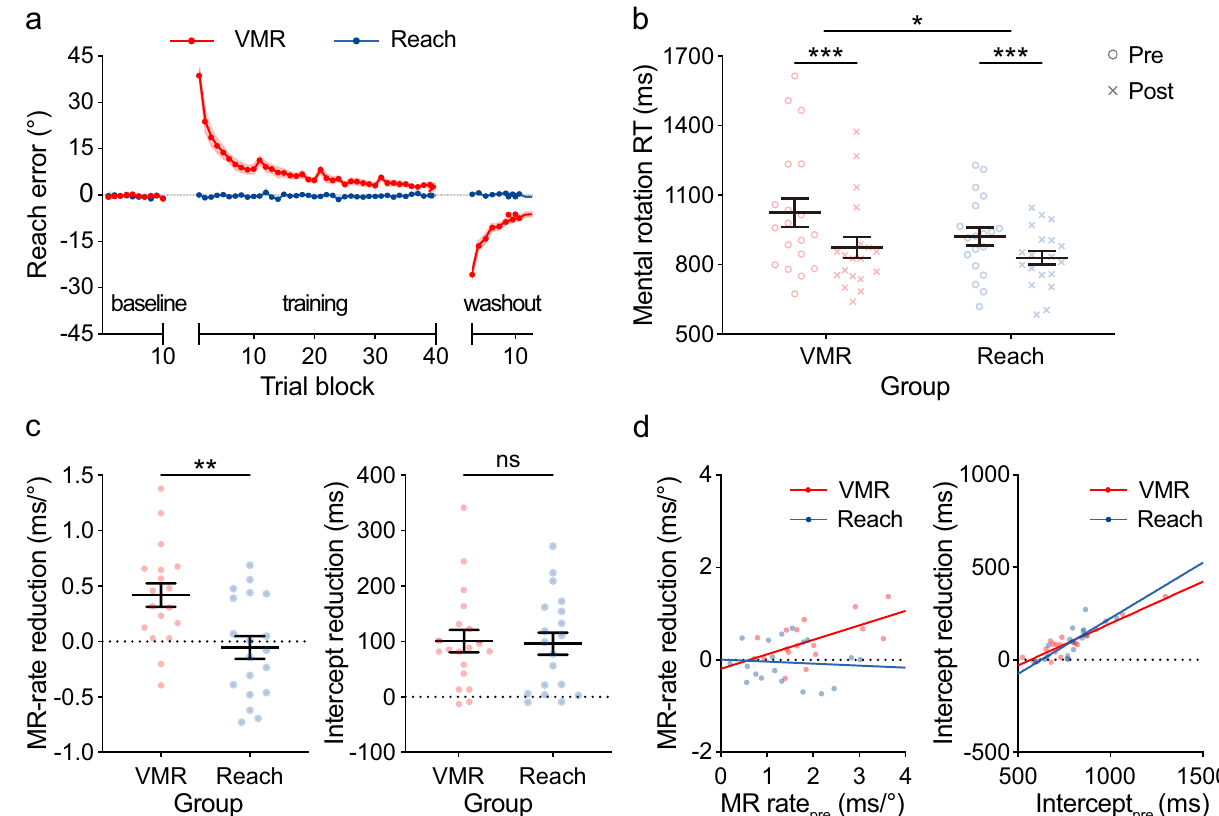
Reach-1.0 VMR Figure 2. Results of Experiment 1. ( a ) Reach error of VMR (red) and control reach (blue) groups in the baseline, visuomotor training, and visuomotor washout session. ( b ) Reaction time (RT) of mental rotation tasks in the VMR (pre: 1024 ± 62.04 ms (s.e.), post: 873.9 ± 45.24 ms) and control reach group (pre: 921.8 ± 39.08 ms, post: 829.6 ± 29.50 ms). Markers represent individual participants in the pre- (circle) and post-test (cross). Black horizontal lines represent the mean with standard errors of the mean in the corresponding group. ( c ) Reduction in the mental rotation (MR) rate (left) and the intercept (right) from the pre- to post-test in the two groups. Dots represent individual participants. Larger positive numbers indicate larger reduction, i.e., performance improvement. VMR group shows significantly larger MR-rate improvement (0.42 ± 0.11 ms/°) then the reach group after the visuomotor training session (− 0.05 ± 0.10 ms/°), while their intercept improvements are not different (101.2 ± 20.20 ms vs. 96.42 ± 19.96 ms). ( d ) Relation between the pre-test performance and the improvement after visuomotor training in the MR rate (left) and intercept (right) in each participant. In terms of MR rate, less efficient participants in the pre-test improve significantly more after the visuomotor training in the VMR group (y = 0.31*x−0.19; R 2 = 0.36 , p = 0.011), while there was no difference in the control reach group (y = − 0.04*x + 0.01. R 2 = 0.01 , p > 0.250). In terms of intercept, participants with a larger intercept in the pre-test shortened their RT more in both groups after training (VMR: y = 0.45*x−257.1, R 2 = 0.86 , p < 0.001; control reach: y = 0.60*x−376.7, R 2 = 0.66 , p < 0.001). In ( a )–( d ), the colors of the markers and lines correspond groups (* p < 0.05, ** p < 0.01, *** p <